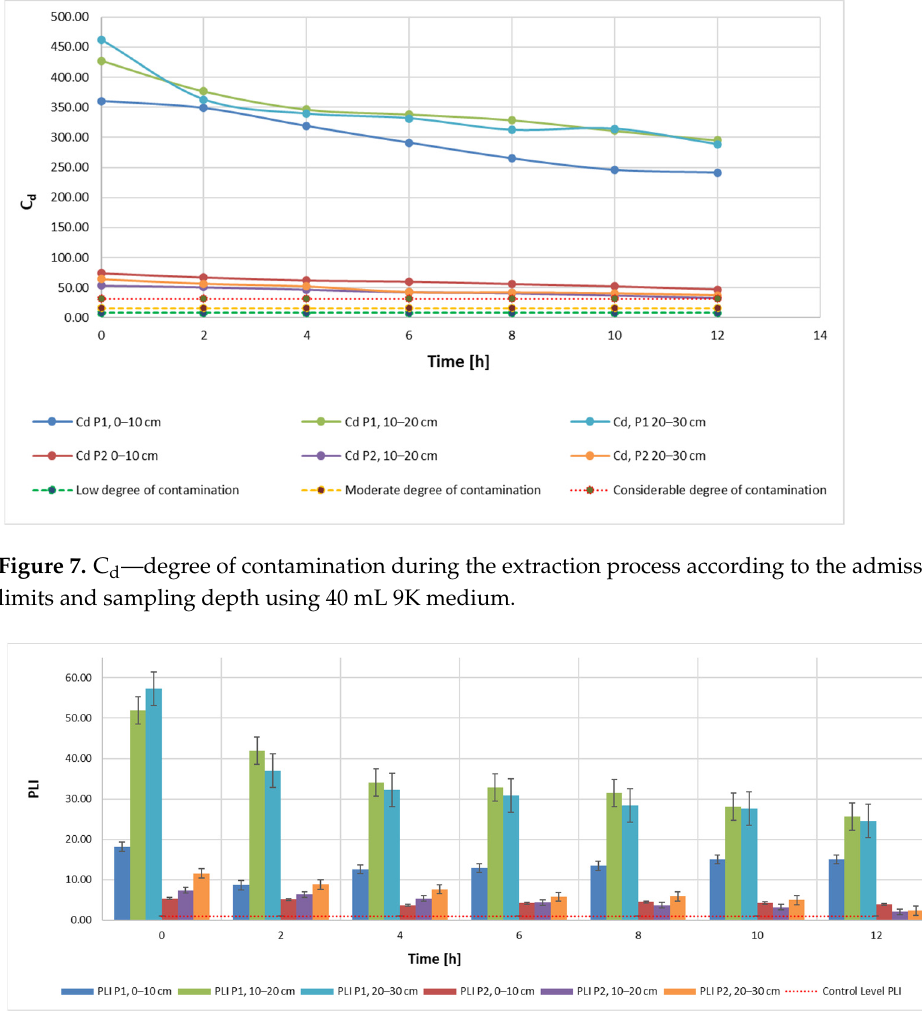
Figure 9. PERI—potential ecological risk index during the extraction process depending on the ad- missibility limits and sampling depth using 40 mL 9K medium. Most of the soil samples presented C f ≥ six values, resulting in a very high degree of pollution (Table 2). Although samples have shown high values in terms of the analyzed parameters, the C r parameter showed values < one for most samples. A relatively small number of samples (seven samples) had a C f ranging from three to six, indicating